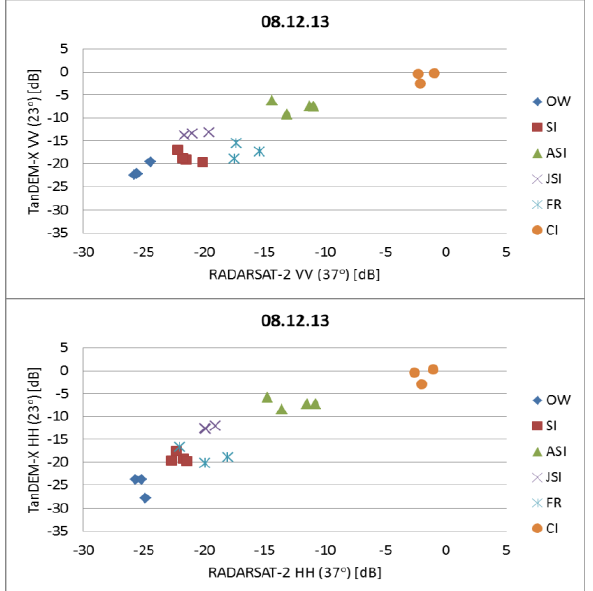
Figure 5 Backscattering values (in dB) for TerraSAR-X and RADARSAT-2 data acquired on 08.12.13. Abbreviations: OW